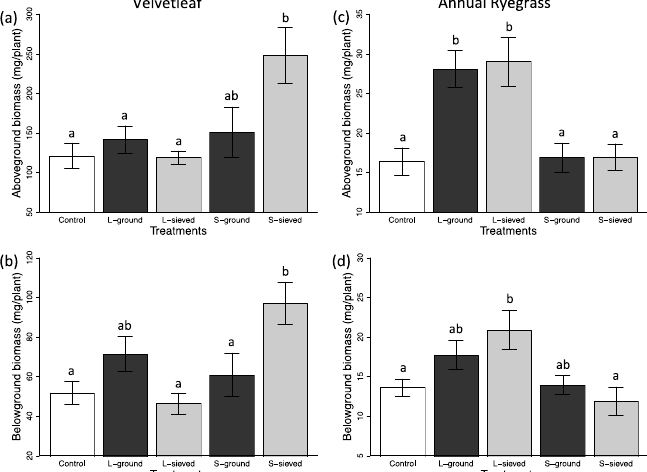
Figure 7. Aboveground ( a ) and belowground ( b ) biomass of velvetleaf; aboveground ( c ) and belowground ( d ) biomass of annual ryegrass. The bar graph indicates the aboveground biomass of the velvetleaf and annual ryegrass on the day of harvest for each treatment and control. Means are plotted ± 1 standard error based on measurements on 7 replicates for each treatment in each plant species. Within each panel, bars with the same lowercase letters do not differ significantly at p < 0.05 according to Tukey’s HSD